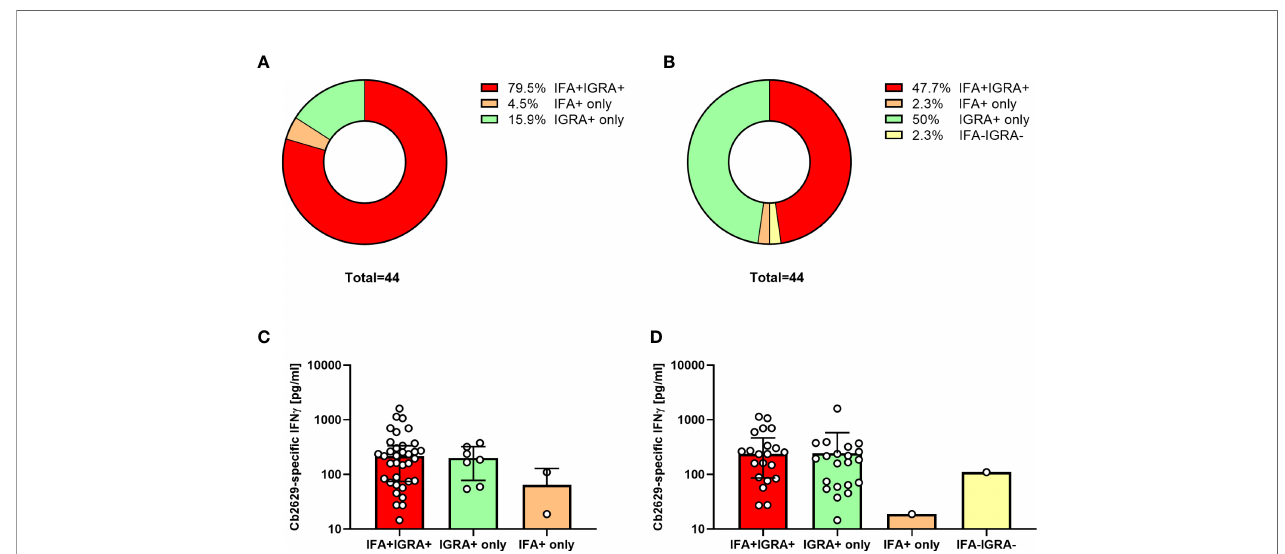
FIGURE 7 | IGRA and IFA results 10-14 years after initial C. burnetii exposure. C. burnetii -speci fi c responses assessed in using the ready-to-use IGRA format (strain Cb2629) and IFA were compared for n=44 individuals with known prior exposure based on both cellular and humoral immunity (positive IGRA and IFA in 2014/ 2015), and a conclusive IGRA response in 2021. Donors were scored as IFA positive using an IgG phase II cut-off titer of 1:64 (A, C) or the of fi cial IFA criteria (IgG phase II titers ≥ 1:256 in case of no detectable phase I IgG; B, D ). Data are shown as the proportion of individuals that scored positive or negative by IFA and IGRA (A, B) or as the median C. burnetii -speci fi c IFN g response and error bars indicating the interquartile range (C, D) . Note that one of the donors treated as IGRA negative in this analysis had a borderline IGRA result (SI 5.0, Cb-speci fi c IFN g response 109 pg/mL; IFA titer